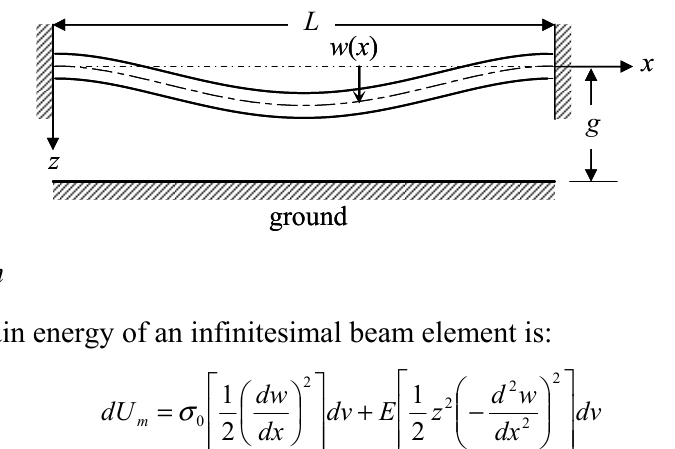
Figure 1. Schematic of the micro fixed-fixed